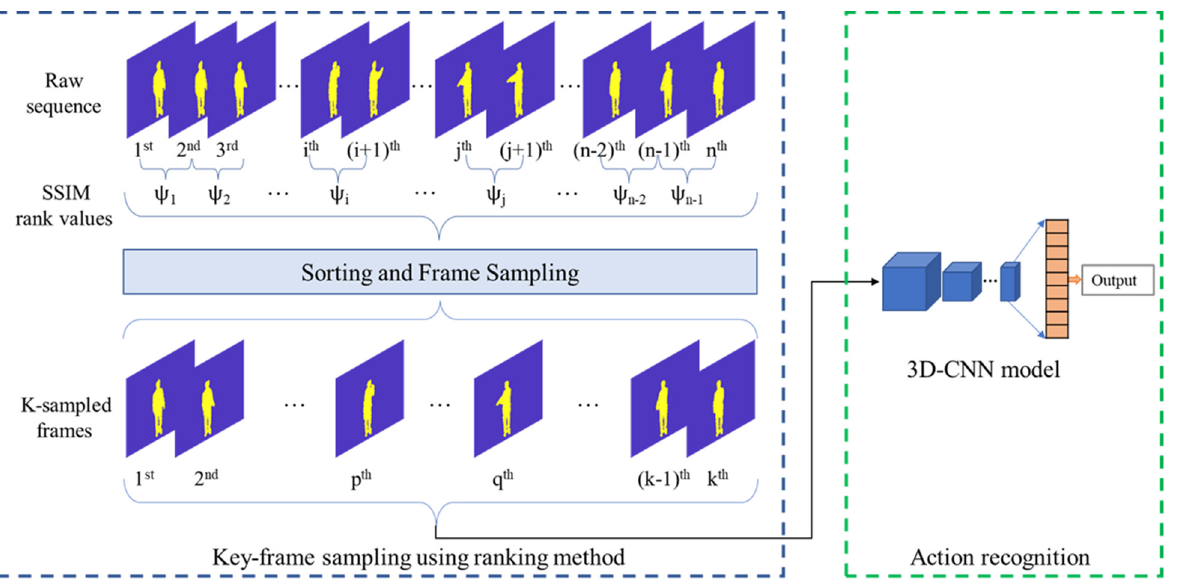
Figure 2. k -ranked key-frames sampling using ranking methods (the background of each depth frames was removed).